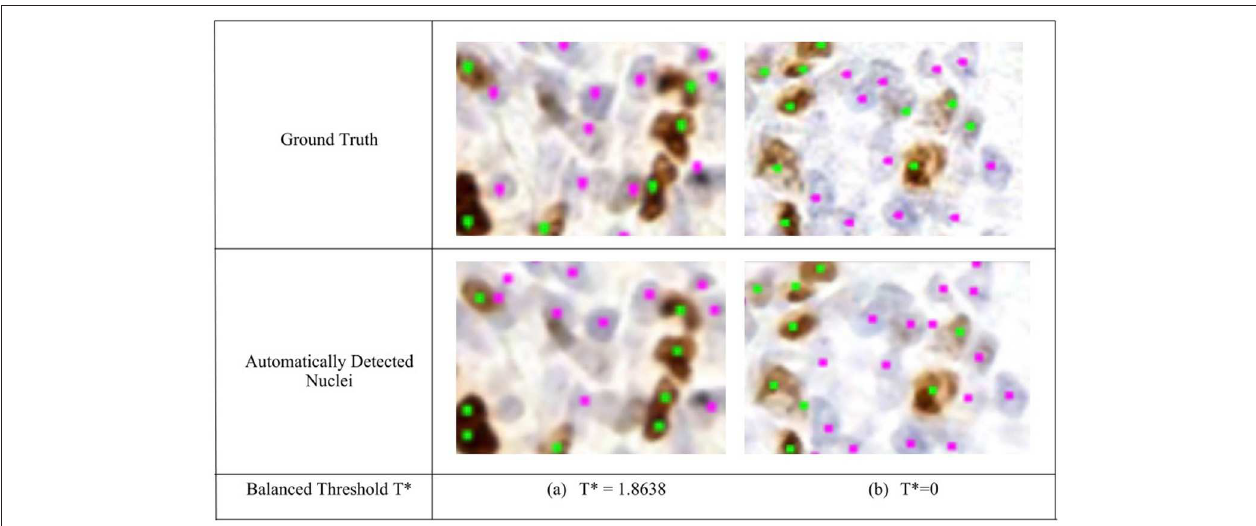
FIGURE 5 | Region of interest from OVC Ki67 TMA. Nuclei detection for H and DAB channels, for automated and manual approaches. ( Top ) Ground truth annotations. ( Bottom ) Automatically detected nuclei using the balanced threshold method. Green marker is for Ki67 + and Pink for Ki67 −